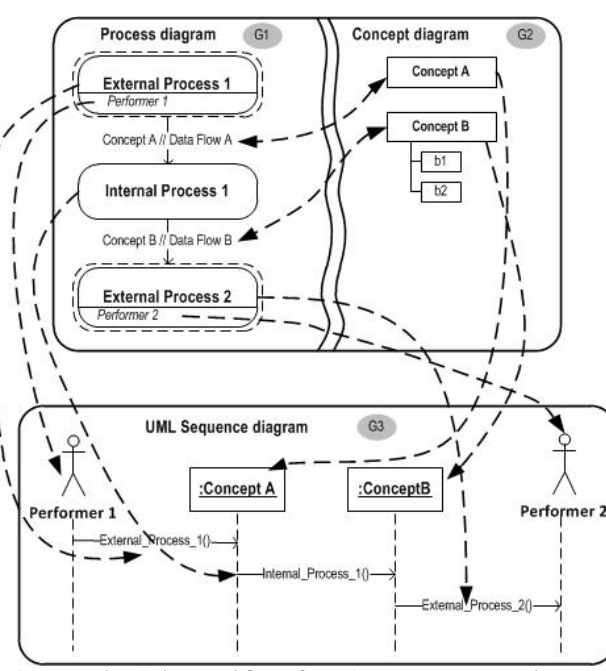
Fig. 4. Two-hemisphere model transformation to UML sequence diagram. The pseudocode shows concept, process and data flow transformation to the relevant UML sequence diagram elements